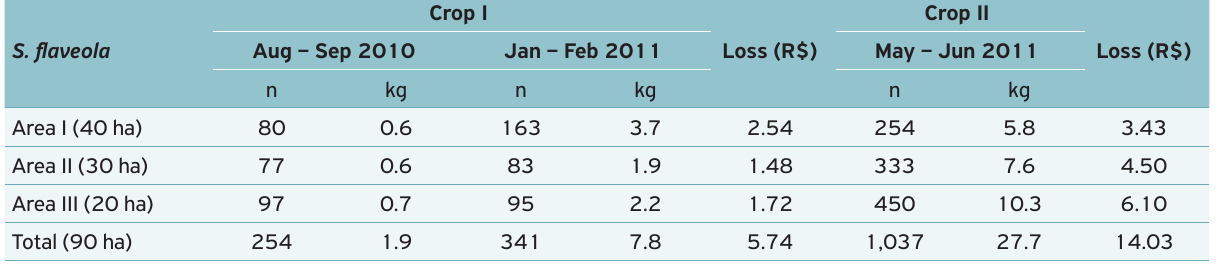
Table 3. Estimated loss of rice by the action of Sicalis fl aveola in the areas sampled.